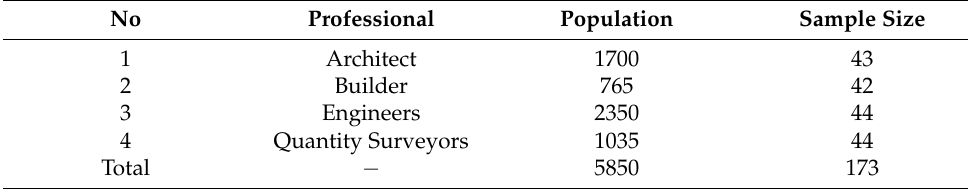
Table 2. Sampling